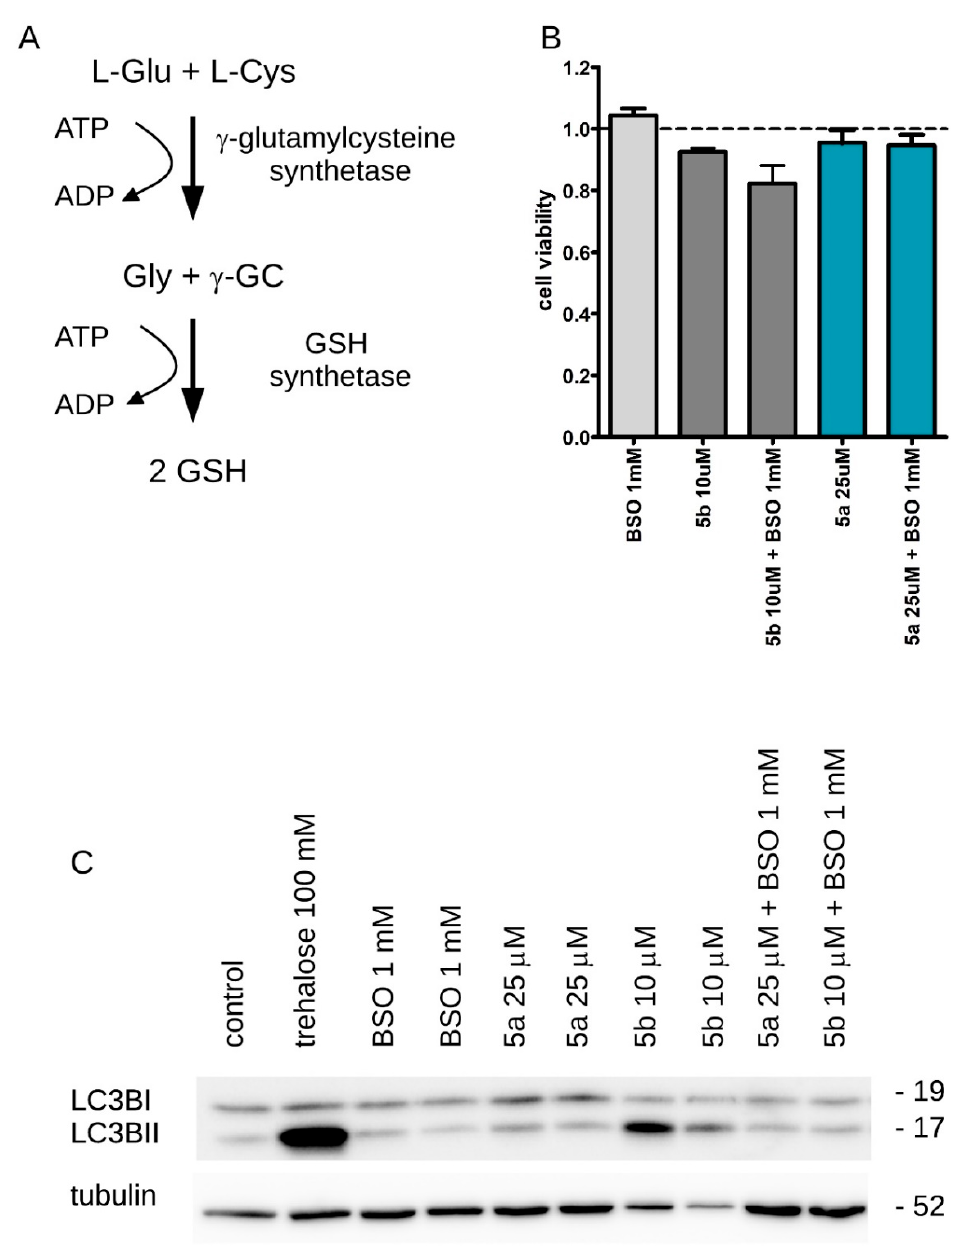
Figure 6. The activity of NAs 5a and 5b is reduction-dependent in cells. We assessed the role of intracellular glutathione on NA activity by Western blotting. ( A ) In eukaryotic cells, de novo synthesis of reduced glutathione (GSH) occurs via a two-step ATP-requiring enzymatic process mediated by two different enzymes, γ -glutamylcysteine synthetase and glutathione synthase. Buthionine sulphoximine (BSO) is an inhibitor of gamma-glutamylcysteine synthetase and, consequently, lowers cellular GSH concentrations. ( B ) Cytotoxicity assay on HeLa cells treated for 24 h with BSO (1 mM) alone, or in combination with 5b (10 μ M) or 5a (25 μ M). Data are presented as mean ± SE; n = 10–15. ( C ) Evaluation of autophagy induction in HeLa cells treated for 24 h with trehalose (100 mM), BSO (1 mM), 5a (25 μ M), 5b (10 μ M), BSO (1 mM) + 5a (25 μ M) and BSO (1 mM) + 5b (10 μ M). Upon treatment, we analyzed α -tubulin, LC3BI and II levels by Western blotting.